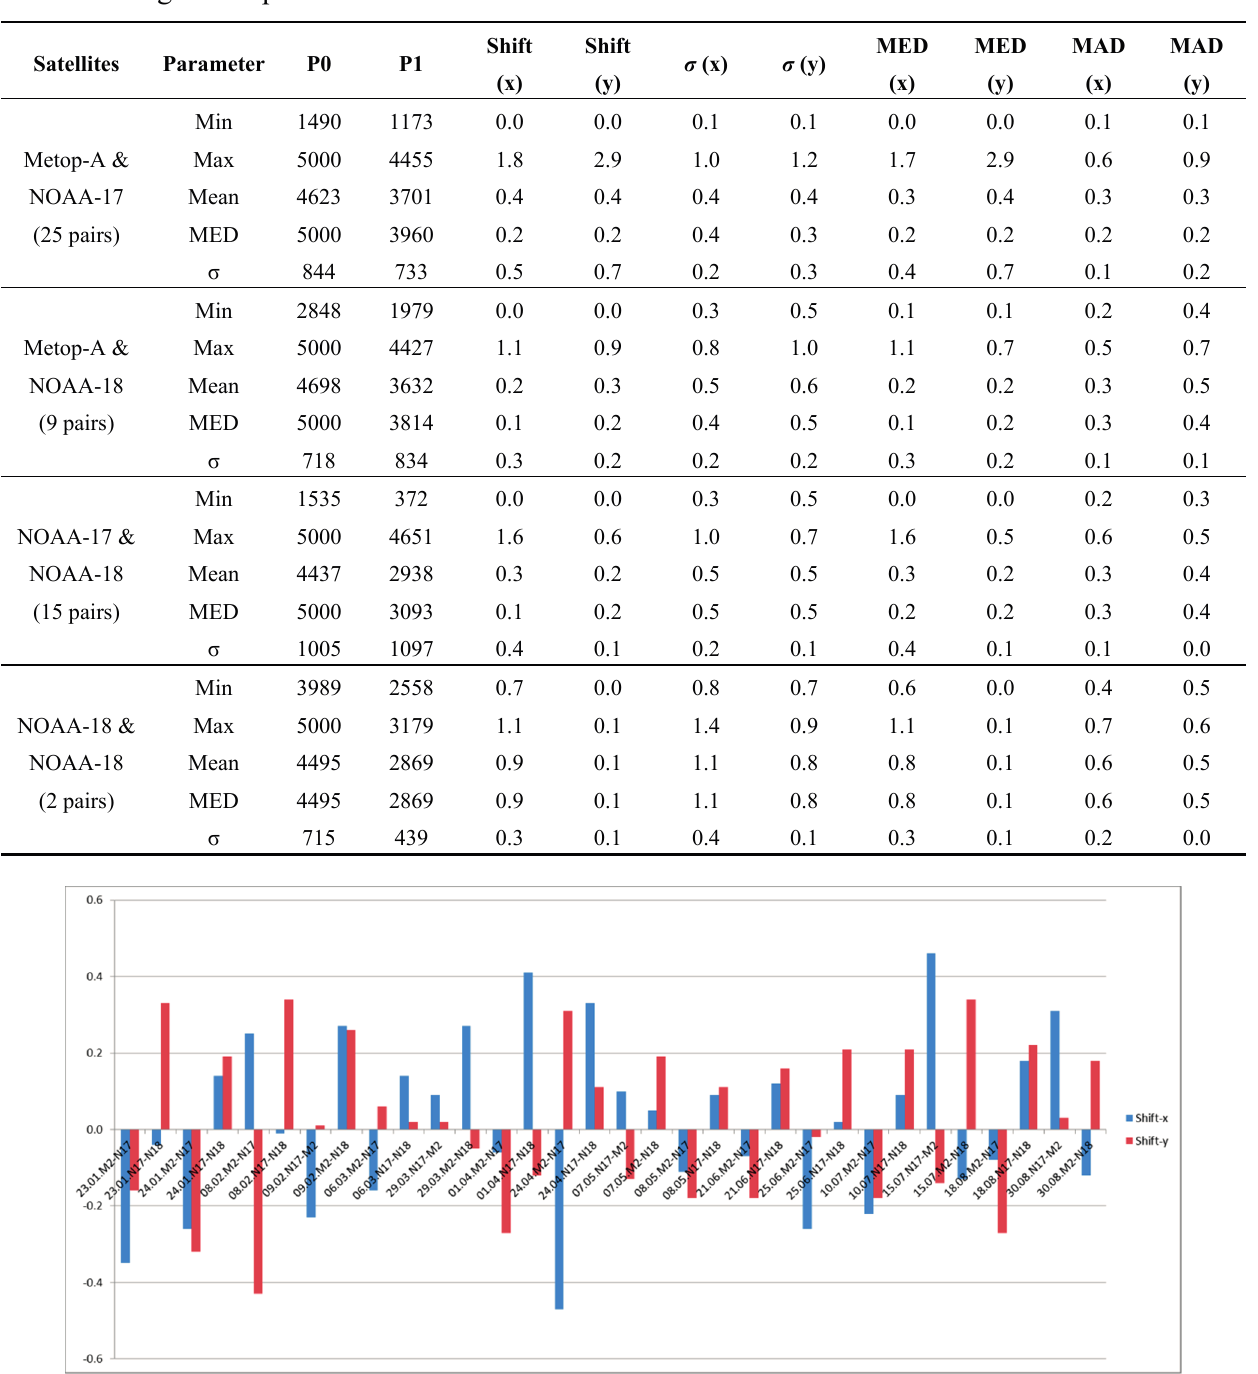
Figure 7. The mean x-, y-shifts obtained from 32 image pairs obtained from Metop-A, NOAA-17 and NOAA-18 between January and August 2008. Horizontal axis: Time, Vertical axis: